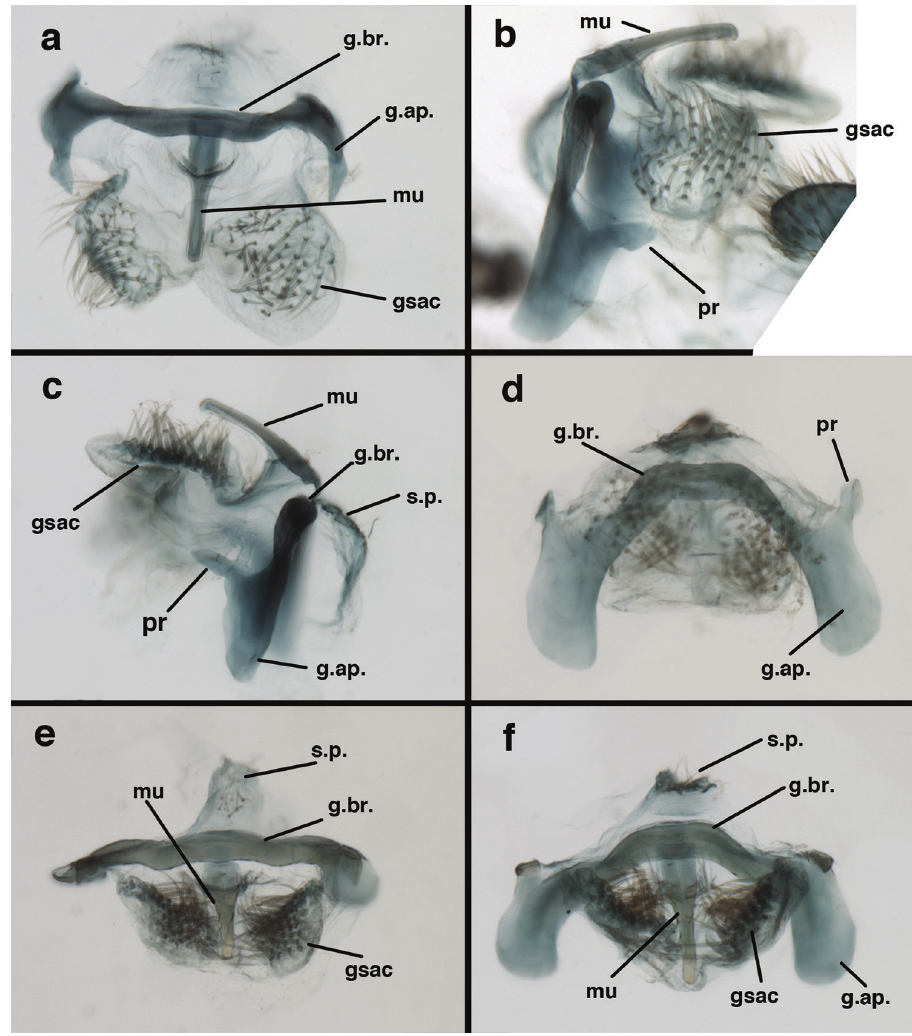
Figure 129. Ungla confraterna (Banks): Male genitalia, ( a ) gonarcal complex, dorsal, gonosaccus ex- panded ( b ) gonarcus, lateral ( c ) gonarcal complex, lateral [Note gonosetae on flat, expanded lobes of gonosaccus.] ( d ) gonarcal complex, posterior ( e ) gonarcal complex, dorsal, gonosaccus withdrawn ( f ) gonarcal complex, frontodorsal, gonosaccus withdrawn. gsac gonosaccus g.ap. gonarcal apodeme g.br. gonarcal bridge mu mediuncus pr unarticulated process on frontal margin of gonarcal apodeme s.p. setose subanal plate (Argentina; a–c Mendoza, USNM; d–f Salta,